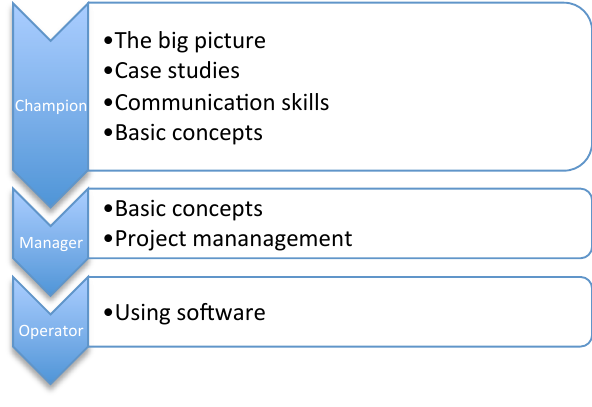
Figure 2. The progression of courses needed at